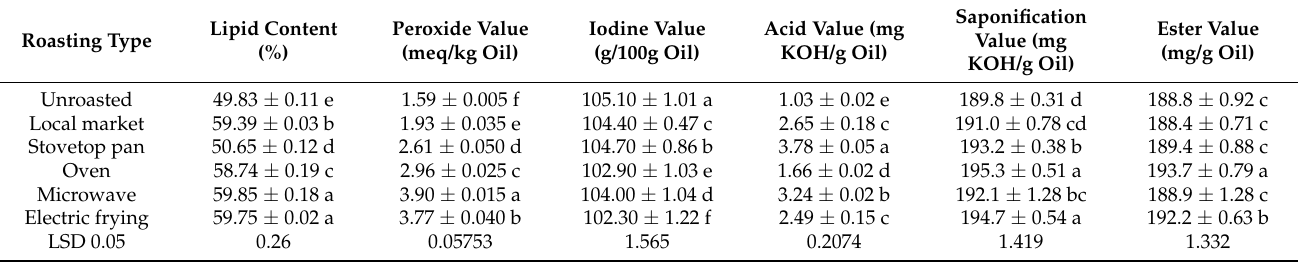
Table 1. Chemical properties of oil recovered from sesame seeds roasted by different